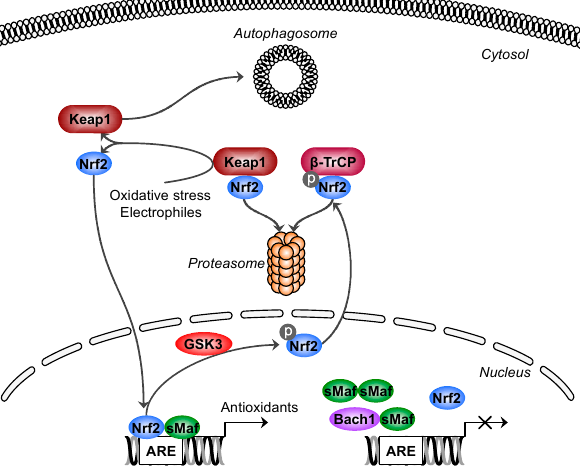
Figure 1. Mechanisms of nuclear factor erythroid 2-related factor 2 (Nrf2) regulation. Under normal conditions, Nrf2 is bound in the cytosol by its negative regulator, kelch-like ECH-associated